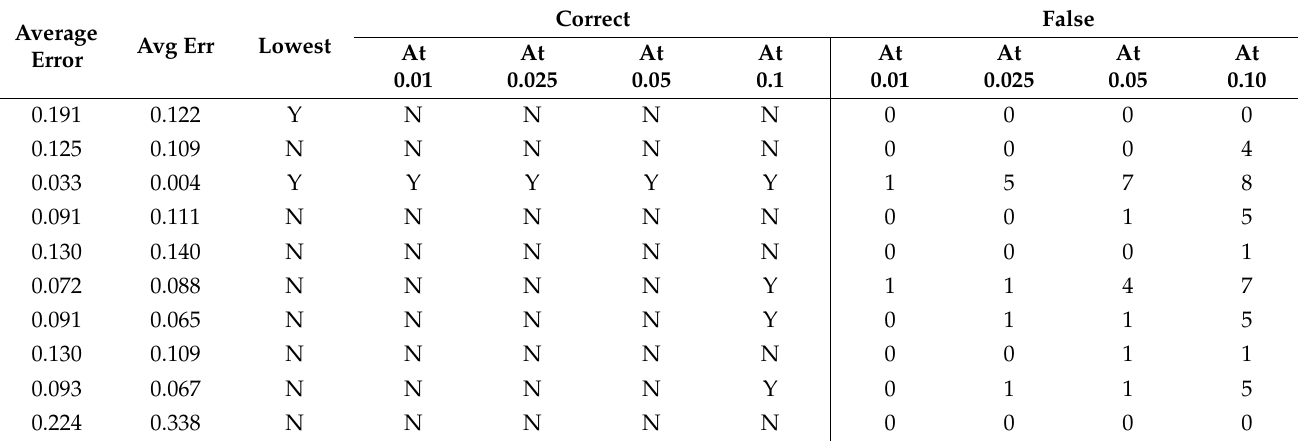
Table A216. Set 3, trials 31–40 summary data (average actual PR